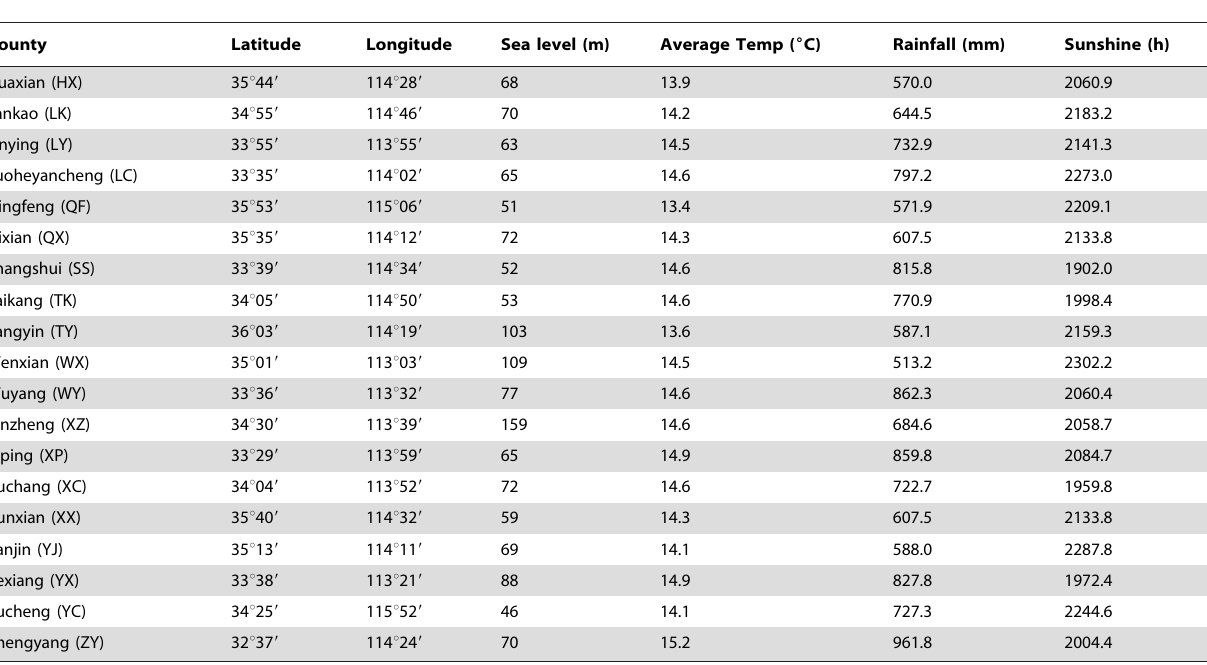
Note: Counties are arranged in English alphabetical order.